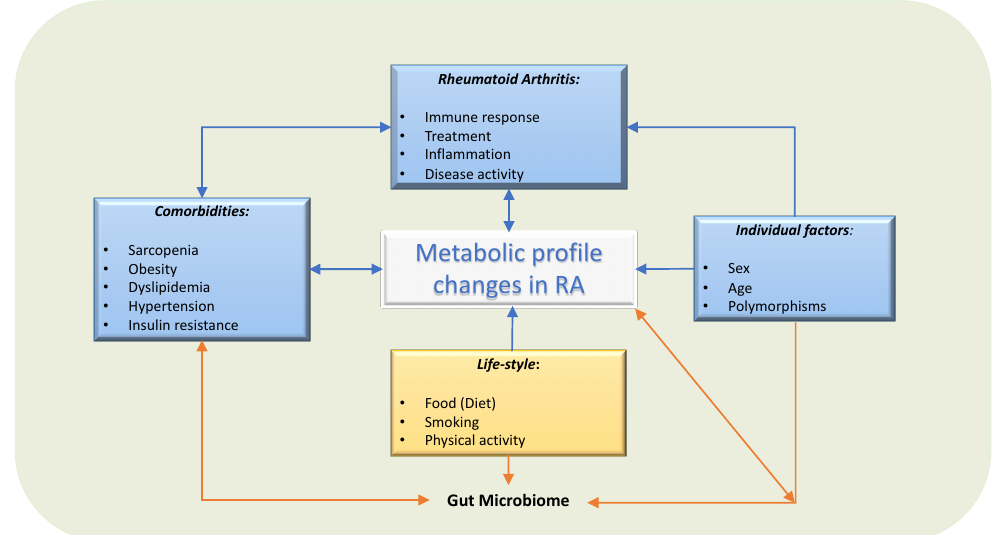
Figure 2. Factors involved in circulating metabolic profile in patients with RA. Several factors influence the circulating metabolites levels. Not only dietary factors or local synovial metabolites, but also comorbidities, treatment and individual factors, such as sex, age and genetics, will modify their metabolism, gut microbiome, and therefore, the circulating metabolic